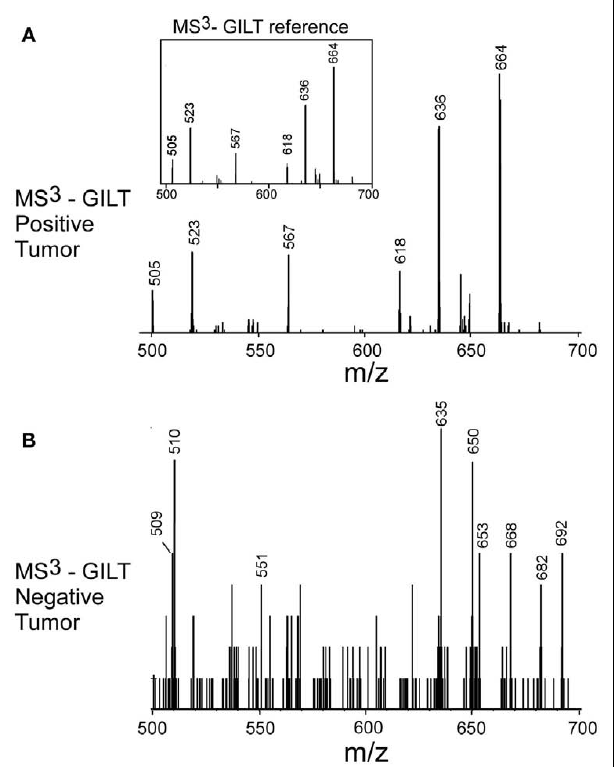
FIGURE 5 | Identifying the HLA-A ∗ 02 bound peptide LLDVPTAAV from the signal sequence of γ -interferon-inducible lysosomal thiol reductase (GILT). (A) MS 3 449.76/781.4 spectrum from a tumor sample that is positive for E7 11–19 identifies abundant GILT signal peptide; the inset shows the MS 3 449.76/781.4 spectrum of a synthetic LLDVPTAAV. (B) MS 3 449.76/781.4 spectrum from tumor sample KTS9 (negative for E7 11–19 ) does not identify the GILT signal peptide even with the high sensitivity analysis employed. Results are from single immunoprecipitation experiments repeated on two different tumor